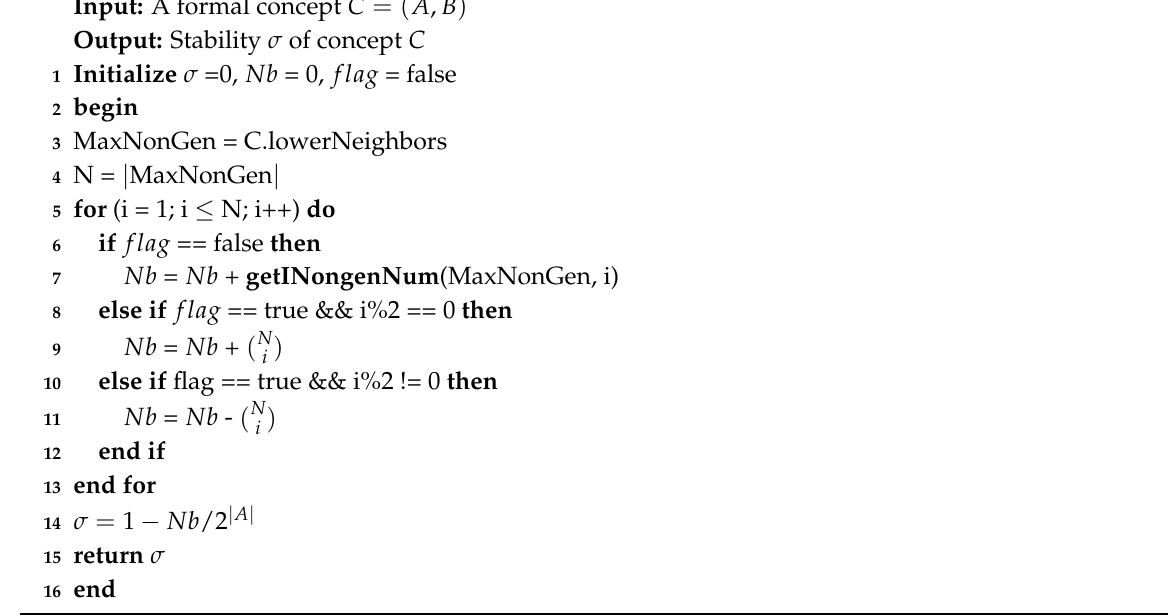
Algorithm 1: Maximal Non-generator-based Stability Calculation Algorithm.